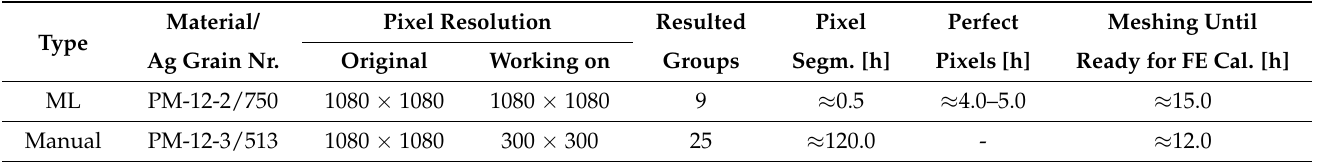
Table 4. Time consuming comparison of image segmentations executed by ML and manual